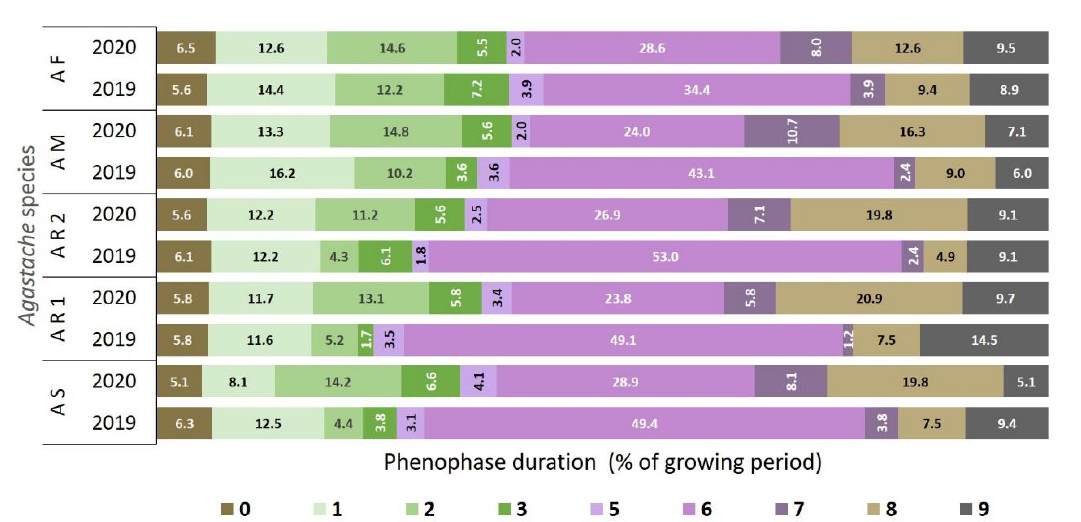
Phenophase Table 5. Duration (number of days) of growth stages of Agastache in Cluj-Napoca conditions. Phenophase